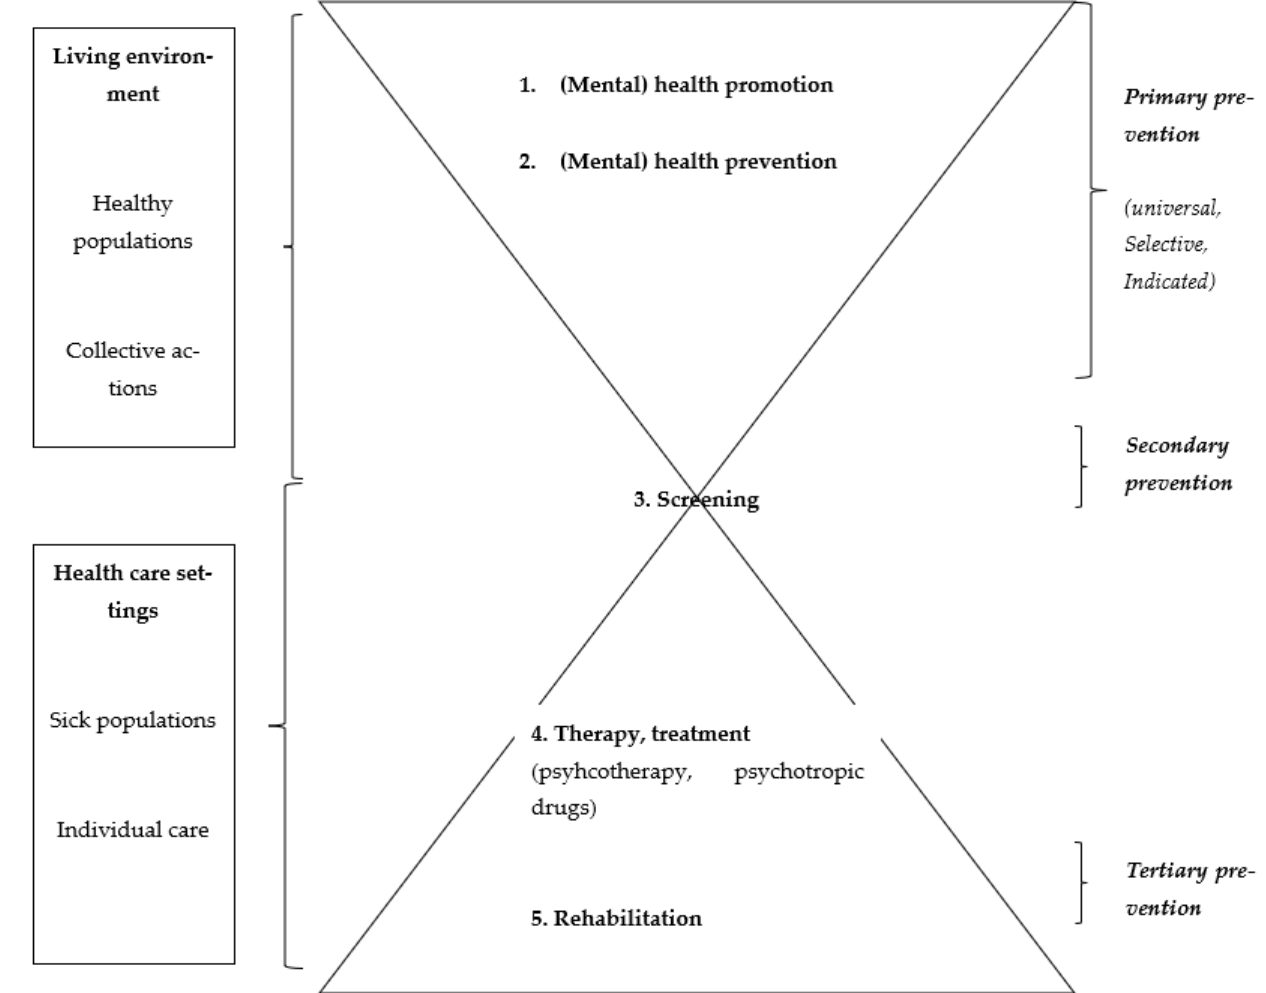
Figure 1. Five levels of (mental) health intervention according to the health status of the beneficiary populations.